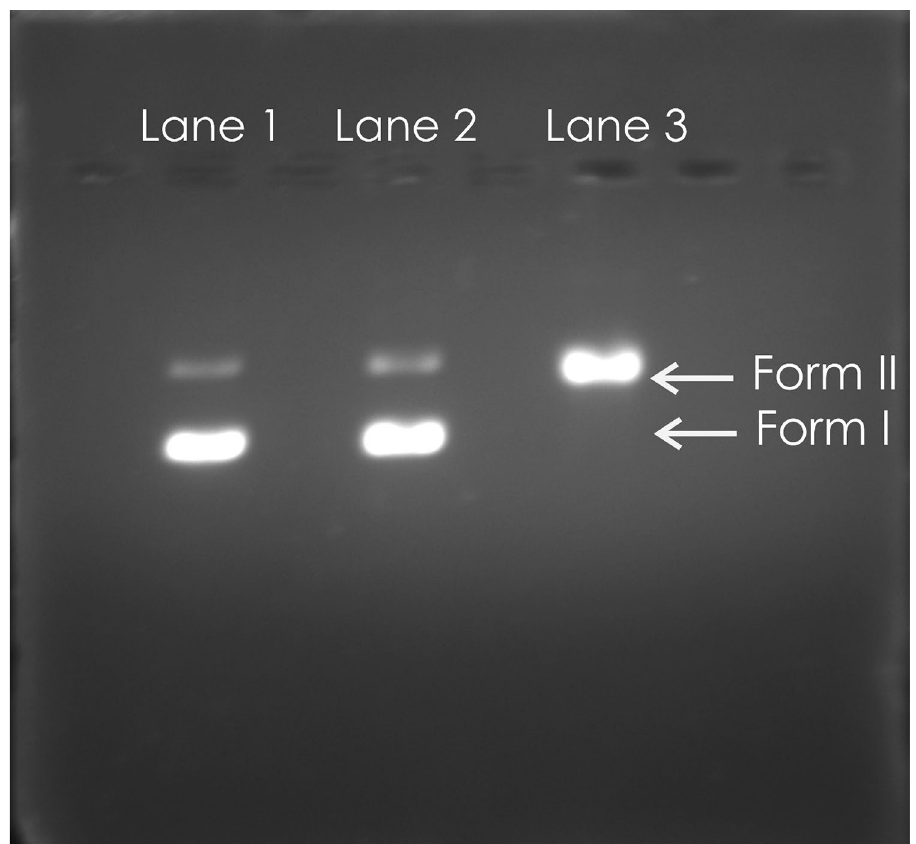
Figure 8. Modification of gel electrophoretic mobility of pUC19 plasmid DNA after treatment with Limonene. Lane 1- Negative control, Lane 2- Pure plasmid, Lane 3- Limonene